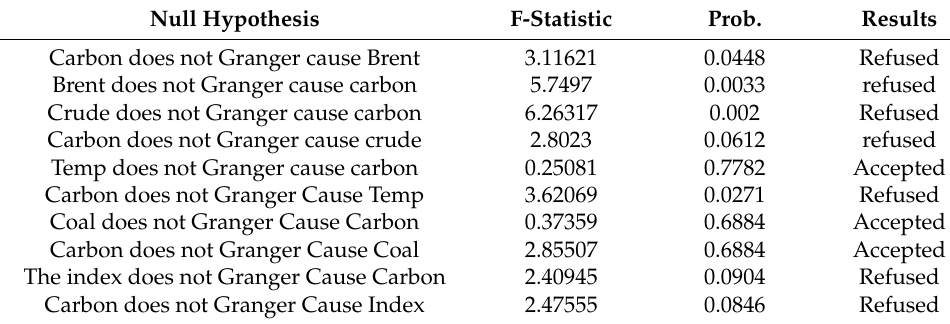
Table 5. Granger causality